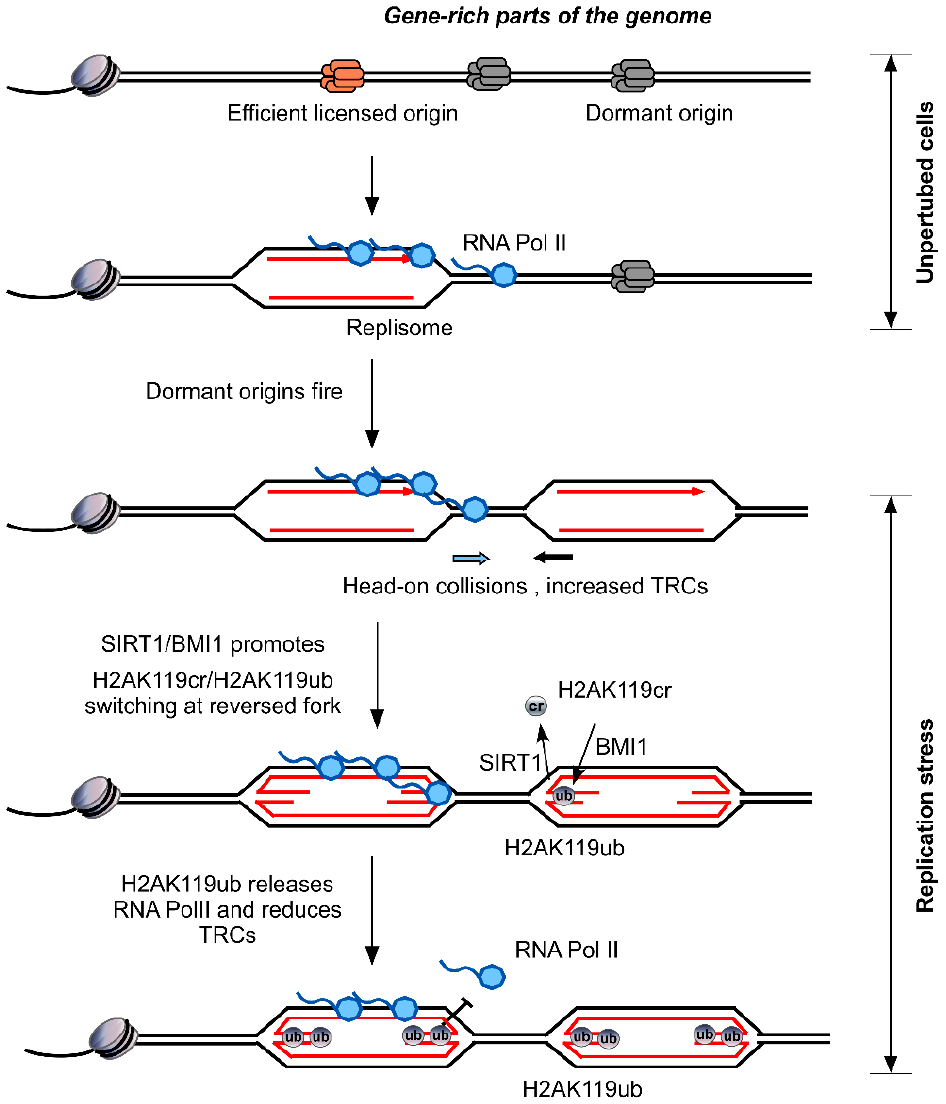
Figure 3. Dynamic switching of H2AK119cr/H2AK119ub reduces replication stress-induced TRCs.